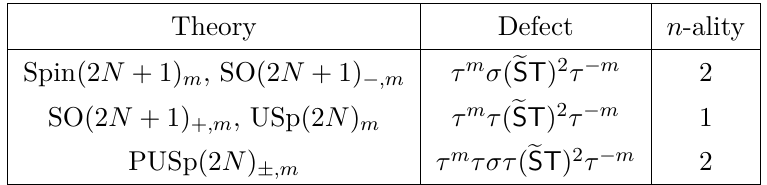
Table 12 . (Non-)invertible symmetries of usp (2 N ) and so (2 N + 1) at τ YM = 1 ± i N even, all defects are invertible and just given by ( e ST ) 2